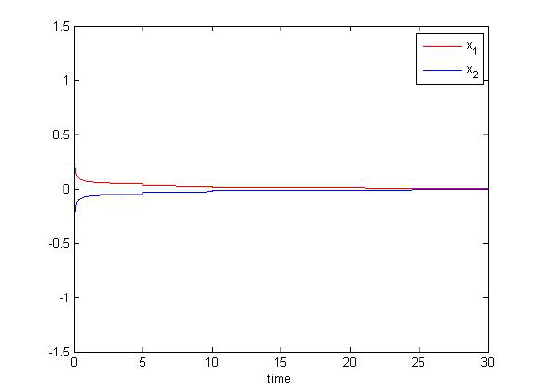
Figure 4. Dynamical behaviors of states x 1 ( t ) and x 2 ( t ) under above